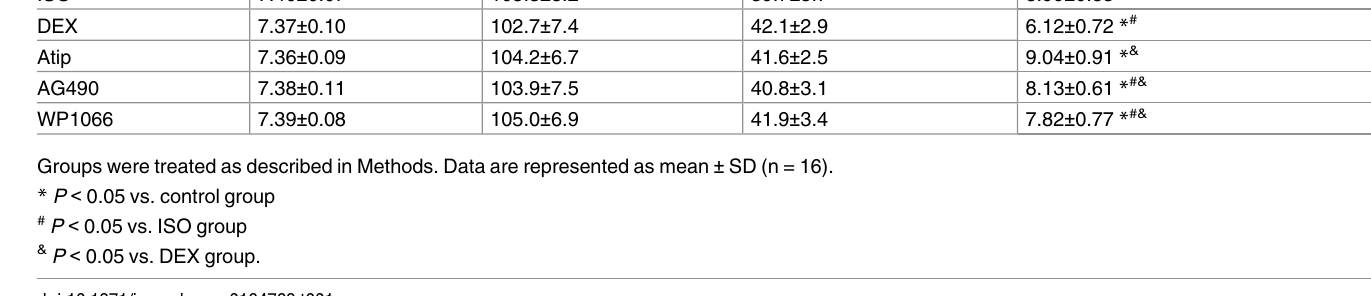
Table 1. Analysis of arterial blood gases and blood glucose in senile mice immediately after isoflurane exposure. Group